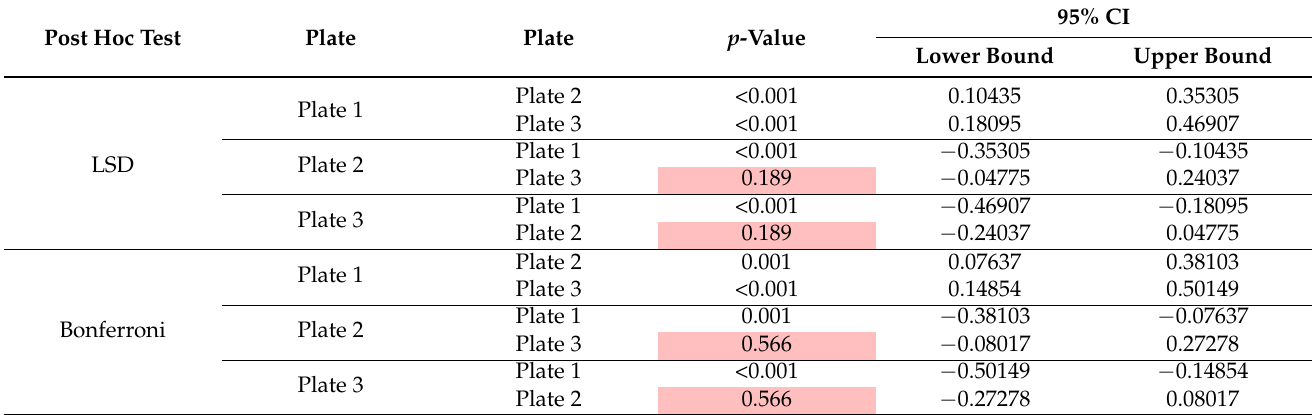
Table 13. Results for the post hoc test were conducted after the ANOVA, analyzing the void volume fraction of the three plates.